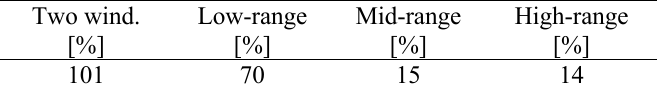
Table 11: Same as Table 10, but with 𝑙 evaluated according to Jenei’s original equation